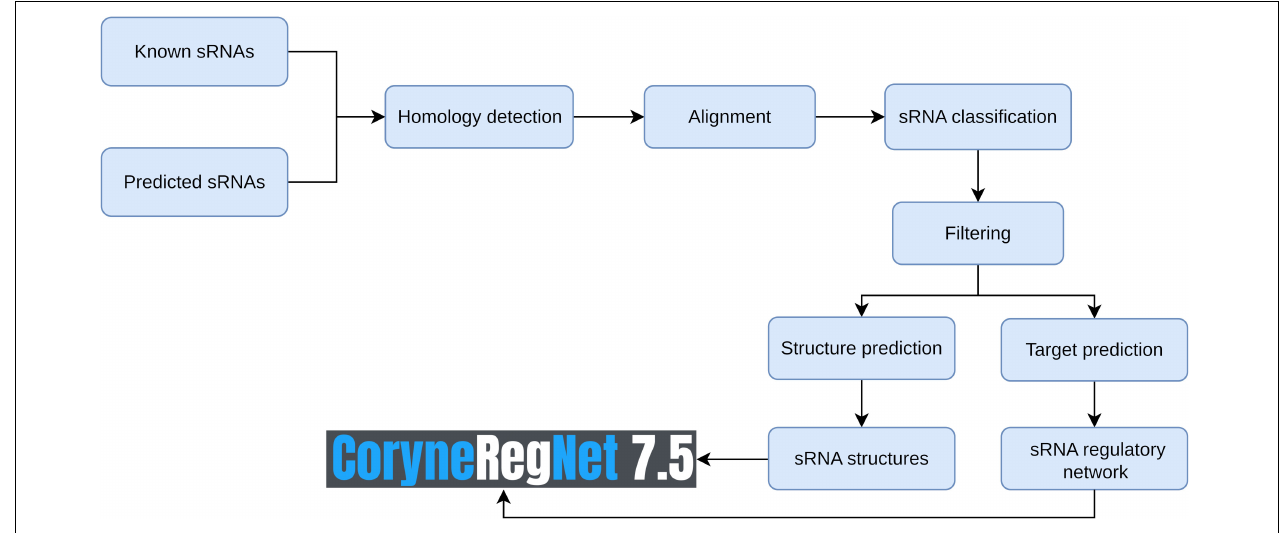
FIGURE 1 | Overview of the sRNA data integration workflow.